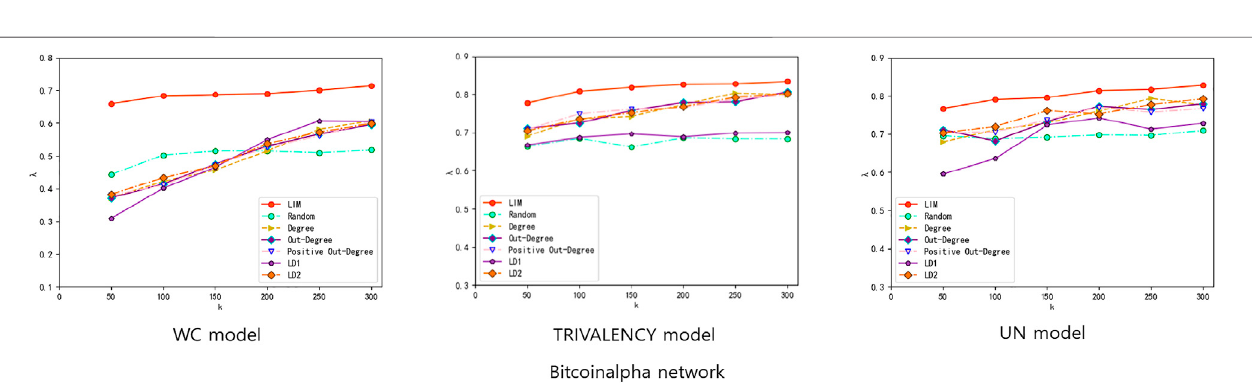
FIGURE 8 | Results of targets set transformation. The experiment is done on Bitcoinalpha. The experiment selects 150 seeds under three models. And the center node of the targets is node 1 which has the highest coreness. Same as the above experiments, the LIM method compares with other 6 methods.